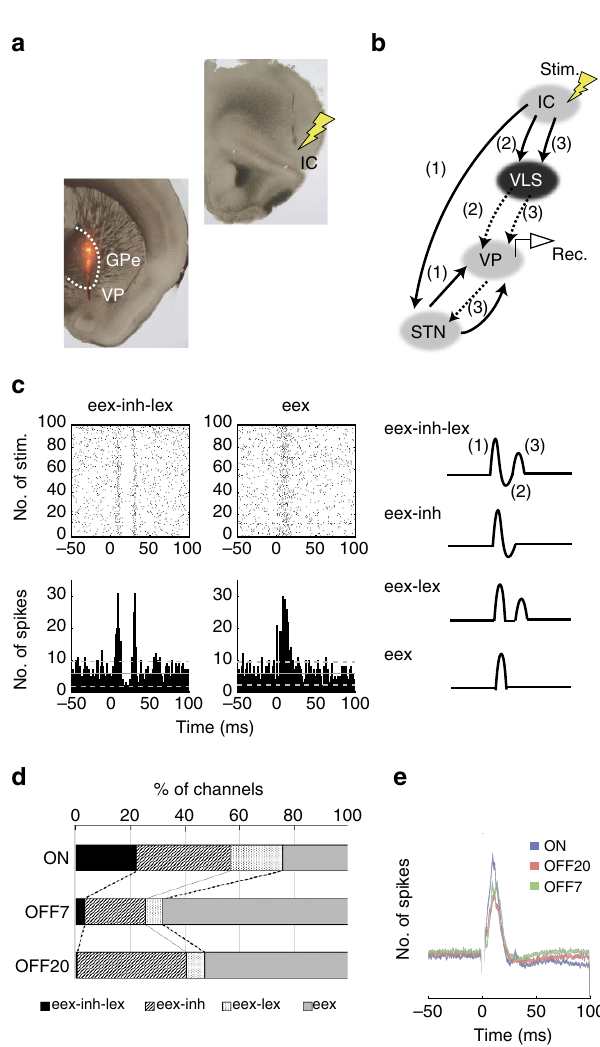
Figure 3 | Electrophysiological characterization of DTA-exposed but viable D2-MSNs. ( a ). Positions of stimulation (arrow at the insular cortex (IC)) and recording (red) are shown. Note that the ventral pallidum (VP) is located beneath the globus pallidus externa (GPe) in this AP position. ( b ) Schematic representation of the pathways from the stimulation site to the recording site. Pathway 1 (IC-subthalamic nucleus (STN) -VP) drives the early excitation; pathway 2 drives inhibition (IC-VLS-VP); pathway 3 (IC-VLS-VP-STN-VP) drives the late excitation. Solid and dotted lines represent glutamatergic and GABAergic pathways, respectively. ( c ) Raster and PSTHs of the typical patterns of eex-inh-lex and eex of VP neurons. inhibition of bilateral Cortical stimulation (200 m s duration single pulse, 200 m A strength) was VLS D2-MSNs during the progressive ratio task. We generated delivered at time 0 for 100 stimulus trials. The mean firing frequency and bigenic animals in which D2-MSNs expressed archaerhodopsin 25 statistical levels of P o 0.05 (one-tailed t -test) calculated from the 100ms ( Drd2 -tTA::tetO-ArchT-EGFP, Fig. 6a; Supplementary Fig. 6A period preceding the onset of stimulation are indicated by solid lines and B, hereafter referred to as D2-ArchT). In vitro electrophy- (mean) and dotted lines (statistical levels), respectively. Four patterns (eex-inh-lex, eex-inh, eex-lex, eex) were classified. eex indicates early- excitation; inh, inhibition; lex indicates late-excitation. ( d ) Proportions of VP neurons (% of traces) classified according to the response patterns evoked by the IC stimulation in controls and D2-DTA DOX-off mice. % of VP neurons with inh and/or lex (patterns with eex-inh-lex, eex-inh and eex-lex in total) was lower in D2-DTA DOX-off mice. ( e ) Difference in the population PSTHs of VP neurons among D2-DTA DOX-on, DOX-off day 7, and DOX-off day 20 groups. The light-shaded colours represent ± s.e.m. NATURE COMMUNICATIONS|8:14304|DOI: